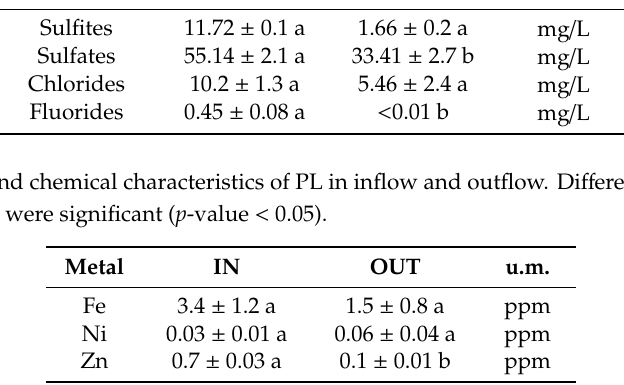
Figure 6. Nitrogen and phosphorus levels before and after phytodepuration. Di ff erent letters indicate that the di ff erences among the means were significant ( p -value < 0.05). Table3. Contentsofsulfites, sulfatesandhalogenatesinwastewaterpreviousandaftertheCWtreatment. Di ff erent letters indicate that the di ff erences among the means were significant ( p -value < 0.05). Contaminant IN